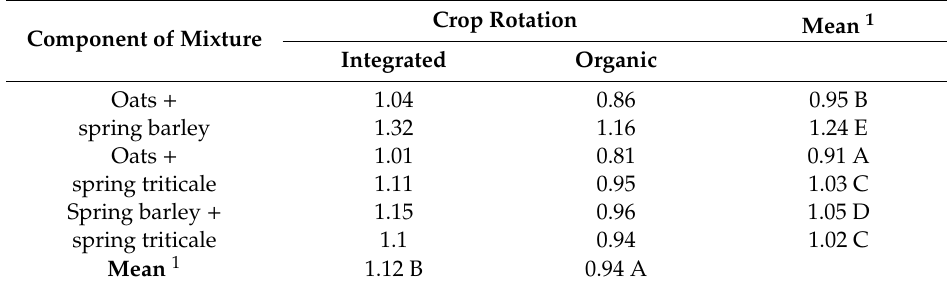
Table 7. Leaf area index (m 2 m − 2 ) of the components of the spring cereal mixtures in integrated or organic crop rotations, means for the years 2011–2019.